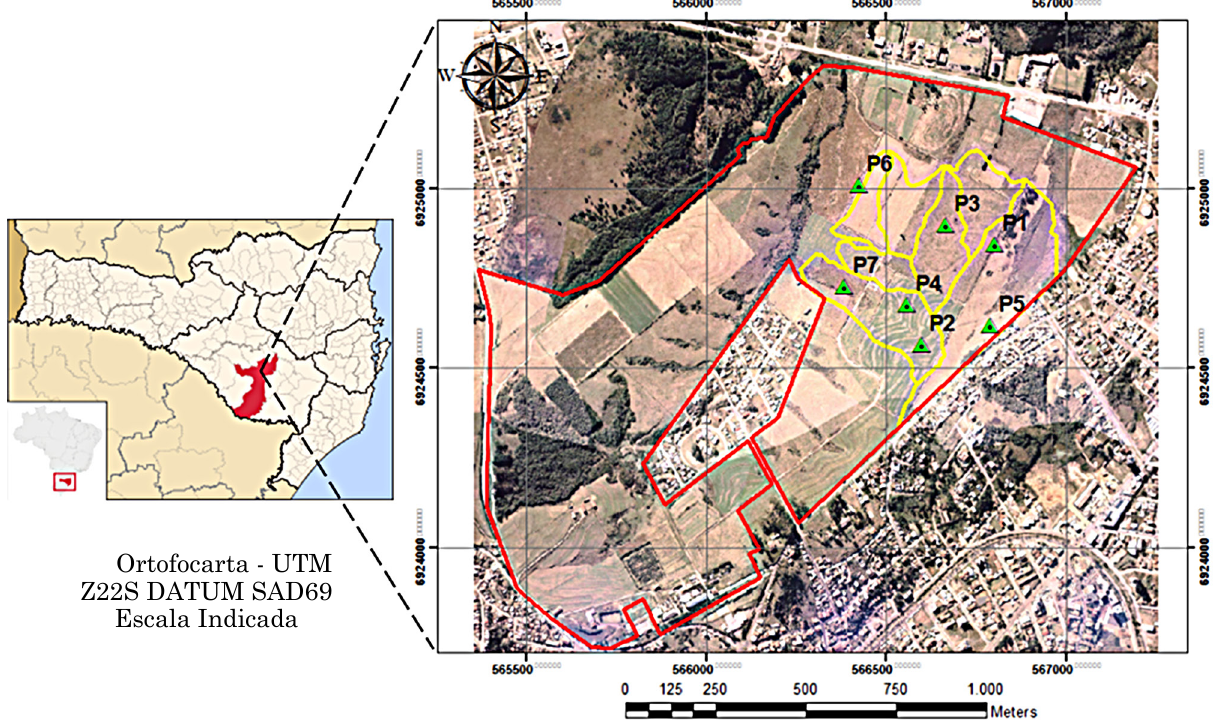
Figura 1. Localização geográfica da área do estudo e dos pedons.